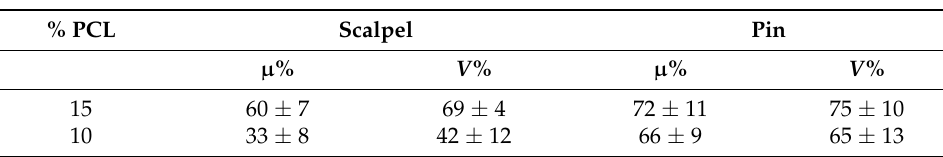
Table 3. Results of the self-healing efficiencies of samples damaged with the scalpel and the pin after heating at 150 °C.